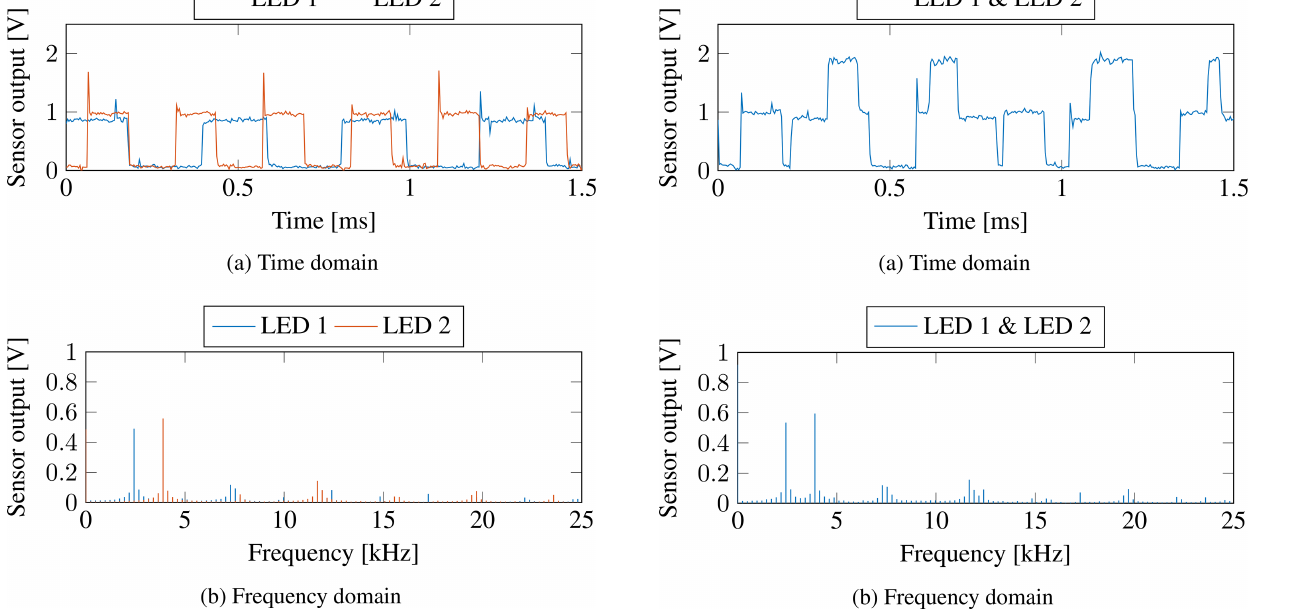
Figure 4. Amplitude modulation and frequency division multiplex- ing with simultaneous control of LED 1 and LED